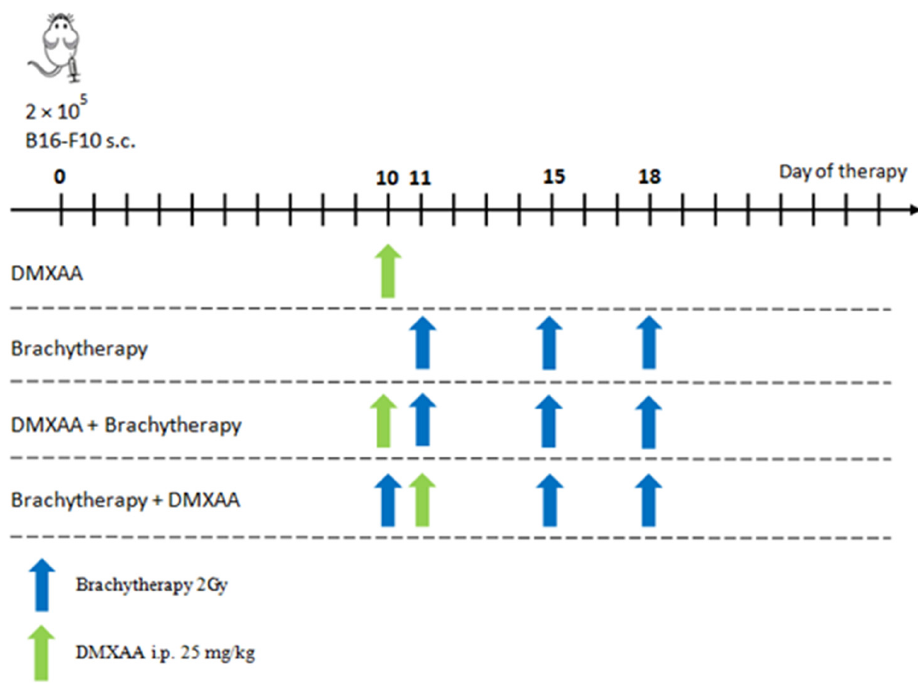
Scheme 1. Diagram showing sequence of brachytherapy and DMXAA administrations.